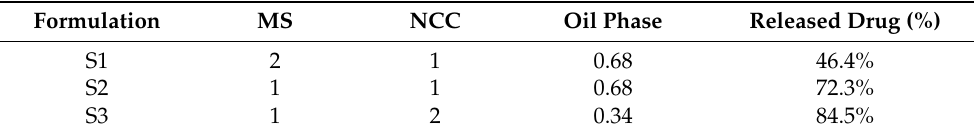
Table 2. Ratio between MS, NCC and the oil—surfactant mixture of three prepared formulations and the percent of released drug from each formulation, determined according to the method described under Section 2.2.5.2. Amount of released